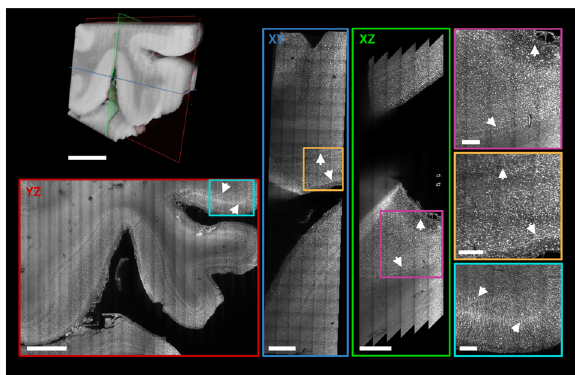
Fig. 3 Higher resolution Mosaic 4 scan of human occipital lobe sample. 3D rendering of a Mosaic 4 acquisitions of a ROI in the vicinity of the human primary visual cortex (left top). Orthogonal views of 50 µ m MIPs ( XY : blue, XZ : green, YZ : red) shows cortical layers independent of the orientation (white arrows). Jagged edges in XZ view result from deskewing when the edge of the acquisition is inside the tissue. Magni fi ed ROIs of the MIP ( XY : yellow, XZ : magenta, YZ : cyan) demonstrate qualitatively the the sample. Scale bars: Volume rendering, XY , and YZ plane 3 mm; XZ